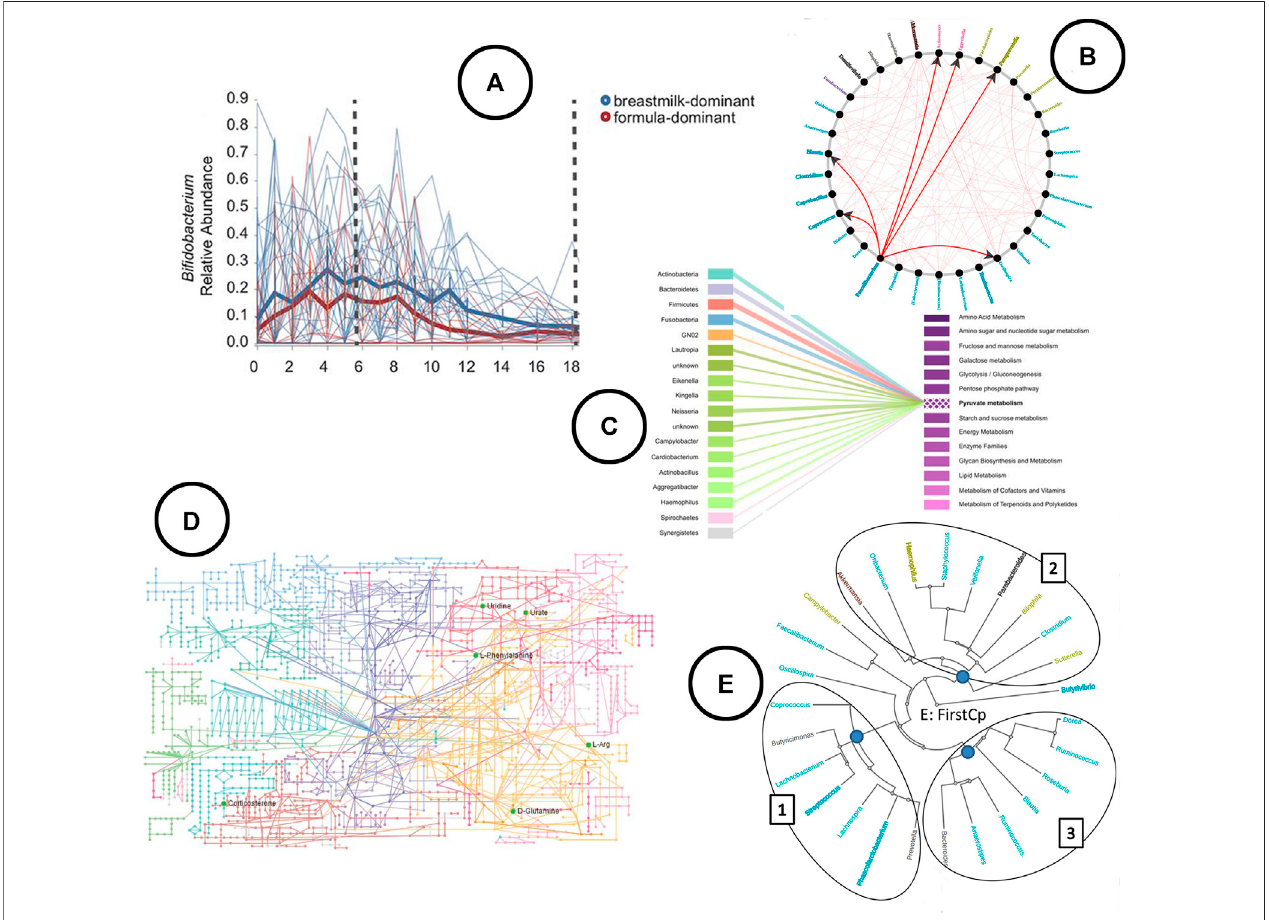
FIGURE 7 | An overview of the visual encodings used to display feature volatility and functional pro fi ling; (A) eveloution of relative abundance over time visualized using a linechart in q2-longitudinal (Bokulich et al., 2018), (B) associations between taxa based on Granger causality testing represented in a node-link diagram in TIME (Baksi et al., 2018), (C) taxa-function relationship displayed using a bipartite graph in BURRITO (McNally et al., 2018), (D) KEGG metabolic pathway network (Zhang et al., 2019), (E) taxa clustered based on similar trends in time in the web-app TIME (Baksi et al.,